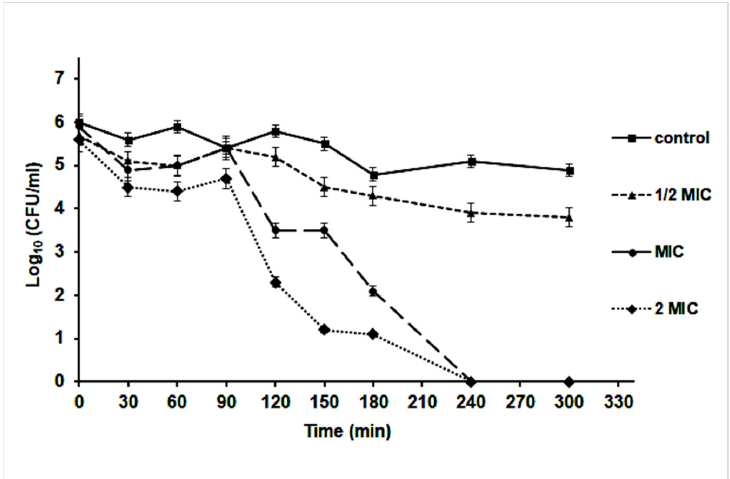
Figure 7. Time ‐ kill curve of S. aureus in Muller Hinton broth medium supplemented with different concentrations of AgNPs. concentrations of